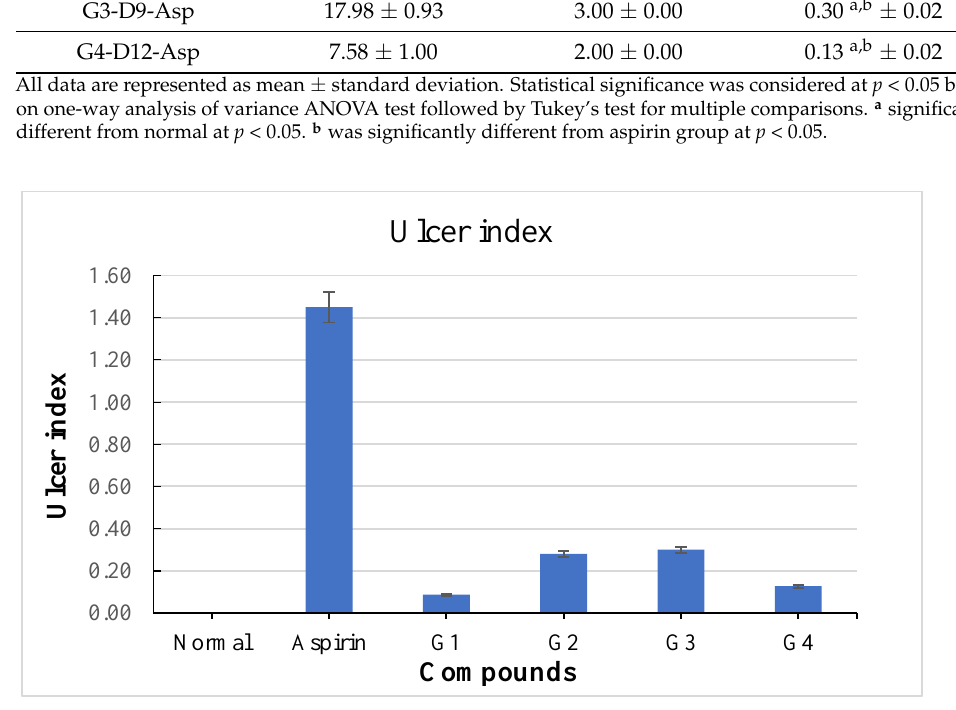
Figure 13. The ulcer index of the tested dendrimer.